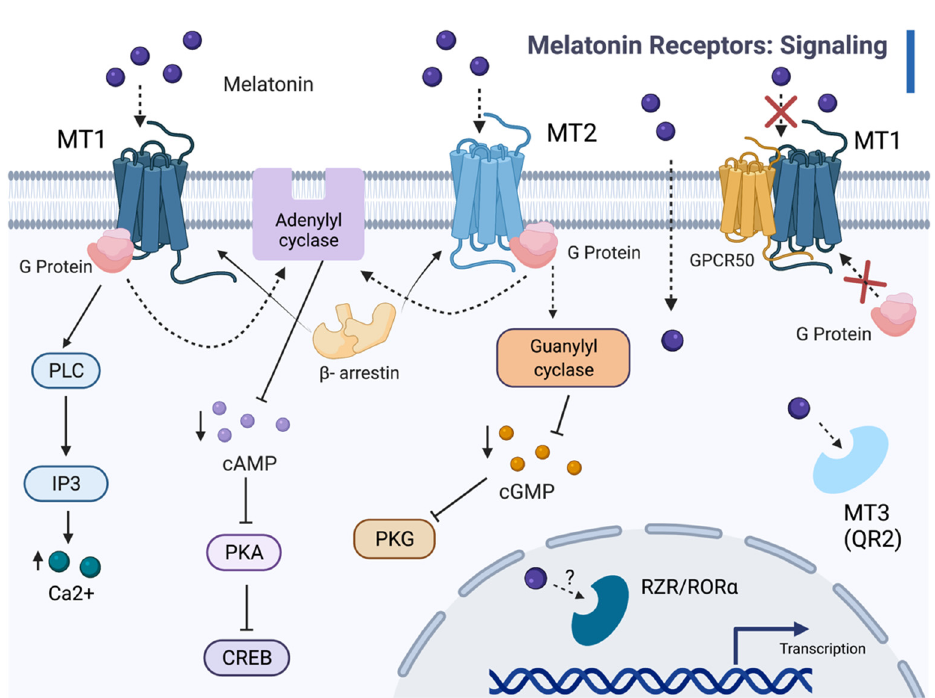
Figure 1. The melatonin signaling cascades. Melatonin binds to transmembrane receptors MT1 and MT2, as well as the MT3 binding site on the cytosolic enzyme QR2, and, possibly, the nuclear receptor RZR/ROR α . Melatonin (ligand) binding with MT1 and MT2 receptors recruits β -arrestin and activates G proteins, which inhibit adenylyl cyclase activity and decrease cAMP levels. MT1 coupling to G proteins activates phospholipase C (PLC), which leads to increased intracellular Ca 2+ . Melatonin-dependent activation of MT2 and associated G proteins prompts interaction with guanylyl cyclase, which reduces cGMP levels; therefore, lowering PKG activity. In vertebrates, except for birds and fish [42,141], heteromerization of GPR50 and MT1 (but not MT2) inhibits both G protein interactions and melatonin binding. Melatonin acts as a ligand for MT3 and, possibly, for ROR α , independently of the MT1 and MT2 pathways. With ROR α and ROR γ , melatonin affects nuclear transcription factor activity and gene expression.